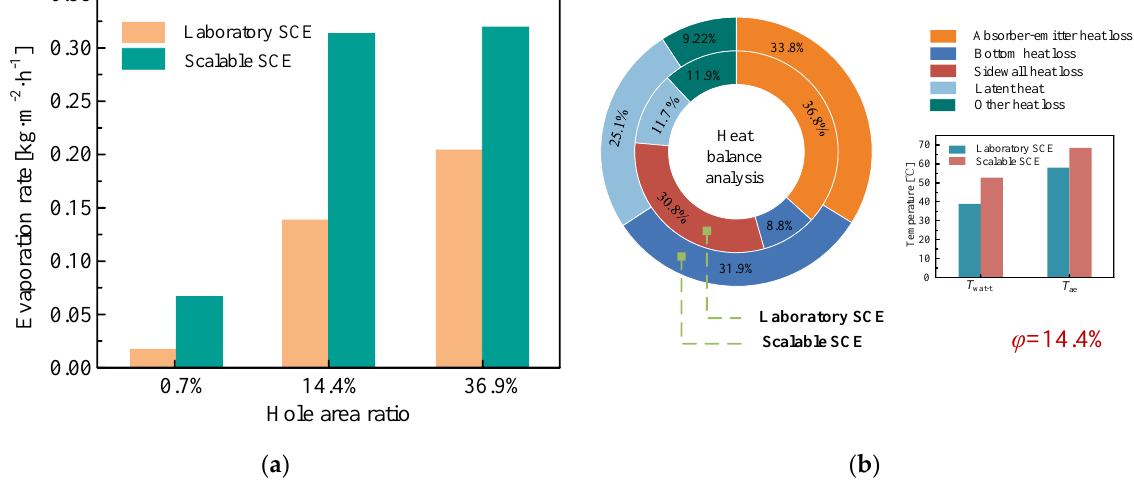
Figure 5. Temperatures from experiment and simulation results.